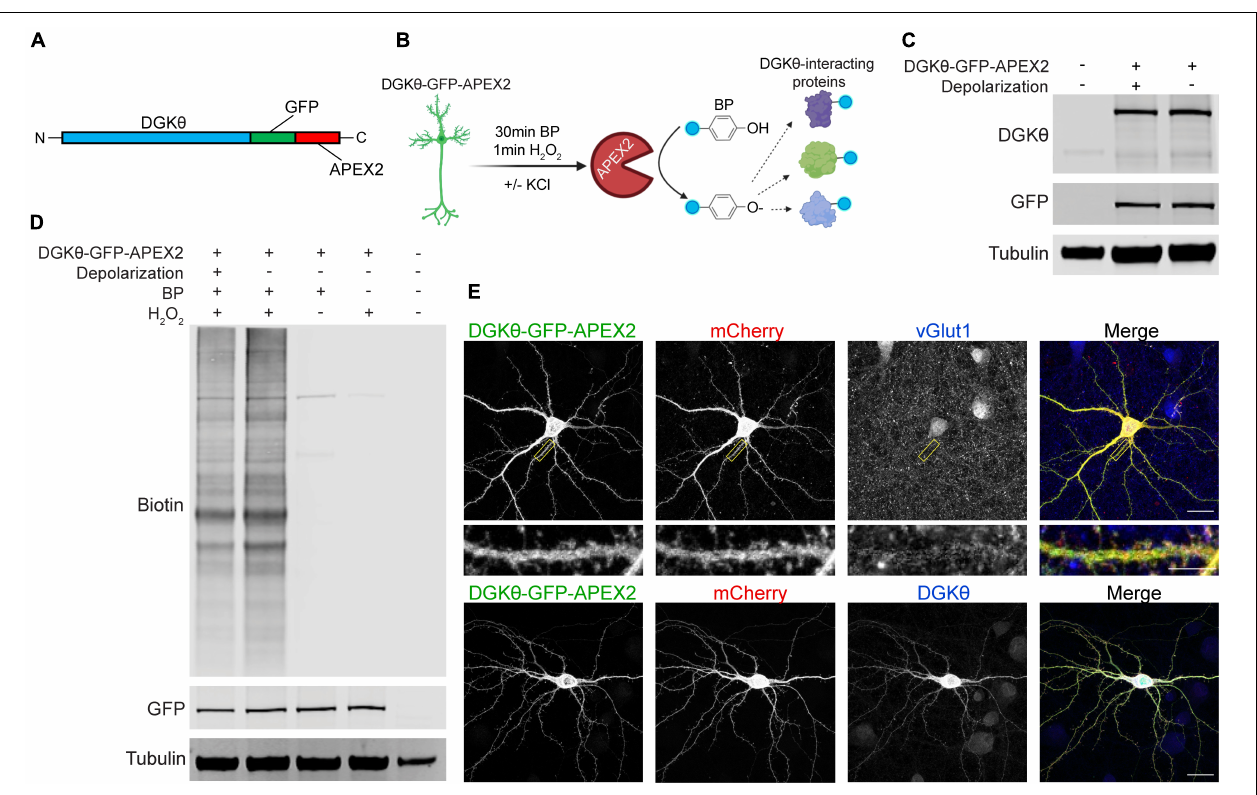
FIGURE 1 | DGK θ -GFP-APEX2 is expressed ubiquitously throughout neurons and labeling of interactors is dependent on H 2 O 2 . (A) DGK θ -GFP-APEX2 was cloned into the neuronal expression vector pCAG. (B) Cortical neurons (DIV21) expressing DGK θ -GFP-APEX2 were incubated with biotin-phenol (BP, 500 µ M, 30 min). Depolarized neurons were treated with a 30 s incubation with 50 mM KCl; control neurons were treated with aCSF. The addition of H 2 O 2 (1 mM, 1 min) catalyzes the reaction. Figure made with BioRender.com. (C) DIV21 cortical neuron lysates express near equal amounts of DGK θ -GFP-APEX2 with and without depolarization. (D) DGK θ -GFP-APEX2 biotinylated proteins with similar efficacy in depolarized and non-depolarized samples, and labeling is dependent on BP and H 2 O 2 . (E) In cortical neurons (DIV19), DGK θ -GFP-APEX2 is localized throughout the cell, in spines, and colocalizes with vGlut1 and DGK θ overexpression. Scale bars represent 20 and 5 µ m (cropped